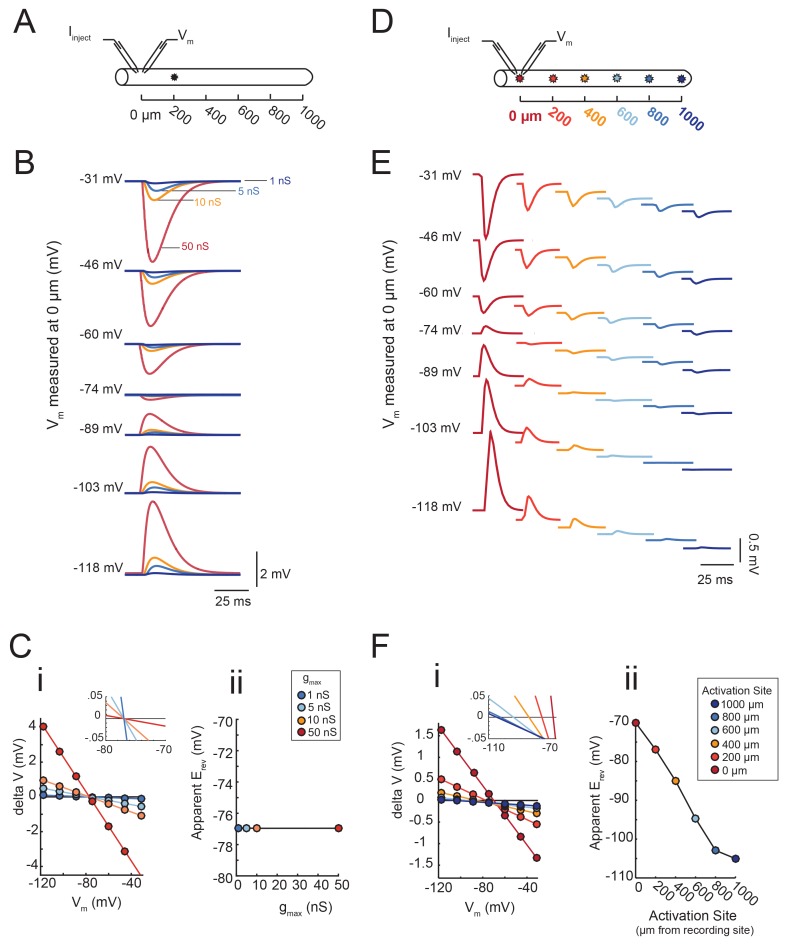
Passive cable simulations show that apparent Erev measurements are independent of maximal conductance (gmax) and dependent on the distance between activation and recording sites.(A) An inhibitory current (actual Erev = −70 mV, τ = 3 ms) was activated 200 µm from the recording site (at 0 µm). (B) Voltage events as measured at 0 µm. The membrane potential at the recording site was manipulated with current injections between −8 and + 2 nA. Colors correspond to responses evoked at 200 µm with different gmax values (as indicated). (C) (i) Response amplitude (deltaV) plotted as a function of membrane potential (Vm) as measured at 0 µm. Apparent Erevs were identified for each gmax by calculating the x- intercept of linear fits to these curves (R > 0.9 and p<0.01 in all cases). The inset shows a magnification along the x-axis and illustrates that all curves share the same x-intercept, regardless of. gmax value. (ii) Apparent Erev plotted as a function of gmax values. (D) To determine the dependence of apparent Erev as a function of activation site distance from recording site, inhibitory currents (Erev = −70 mV, τ = 3 ms, gmax = 5 nS) were evoked at 0, 200, 400, 600, 800,. and 1000 µm from the recording site. (E) Voltage events as measured at 0 µm. The membrane. potential at the recording site was manipulated with current injections between −8 and + 2 nA. Colors correspond to responses evoked at different activation sites (as indicated in D). (F) (i) Response amplitude (deltaV) plotted as a function of membrane potential (Vm) as measured at 0 µm. Apparent Erevs were identified for each activation site distance by calculating the x-intercept of linear fits to these curves (R > 0.9 and p<0.01 in all cases). The inset shows a magnification along the x-axis and illustrates the hyperpolarizing shift in apparent Erev as activation site distance increases. This is explicitly plotted in (ii). The cable model used to generate all of these data had a passive conductance of 20 nS·cm−2 and axial resistance of 30 Ω·cm (see Materials and methods).